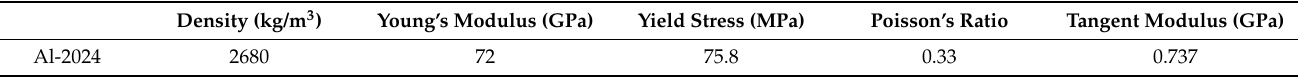
Table 3. Material parameters Table 4. T700s mechanical properties of unidirectional carbon fiber plate [21].